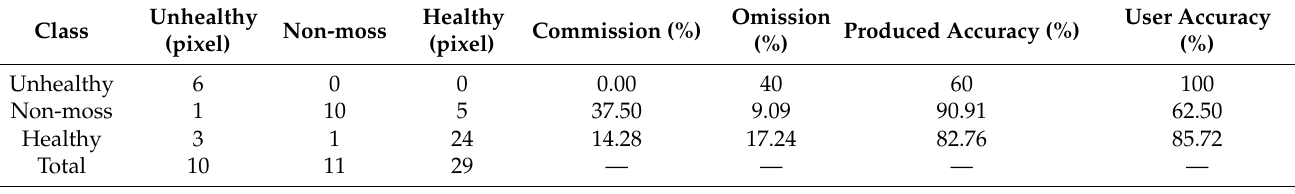
Figure 10. Maps of moss health estimation in 2018 ( a ) and 2019 ( b ). The blue boxes highlight representative areas for mosses showing changed growth status. Table 5. Confusion matrix of mosses health